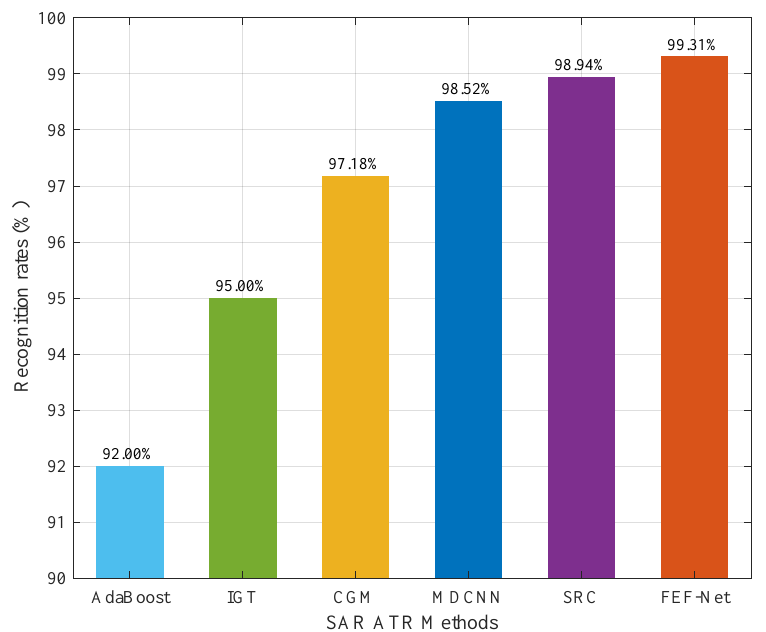
Figure 6. Recognition performances of various